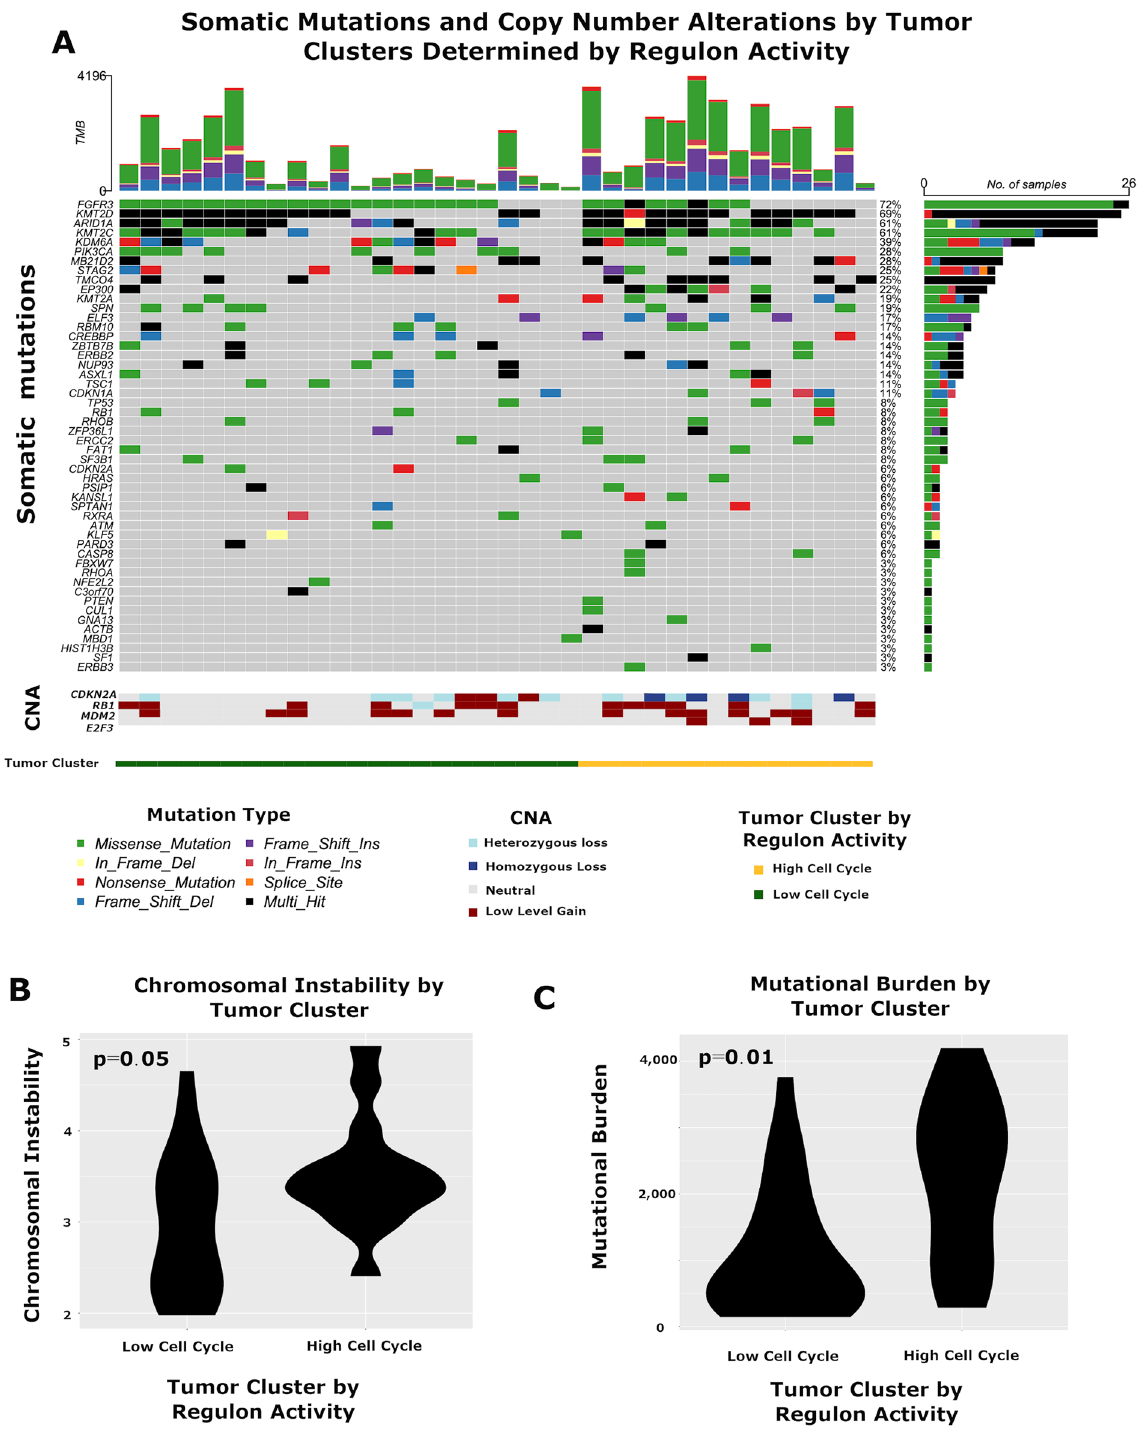
Figure 5. Somatic mutations and copy number alterations on non-invasive papillary urothelial carcinoma. ( A ) Tumors demonstrated somatic alterations common in noninvasive papillary urothelial carcinoma, including somatic mutations in FGFR3 , STAG2 , and multiple chromatin remodeling genes, such as ARID1A and KMT2D , as well as homozygous and heterozygous copy number losses of CDKN2A (CNA = copy number alterations). Tumors in the High Cell Cycle group demonstrated ( B ) greater chromosomal instability and ( C ) higher tumoral mutational burden. Chromosomal instability was defined as the mean of the chromosome-level segmentation means in each tumor. Tumor mutation burden was defined as the total number of somatic mutations per tumor after filtering. All data derived from Cohort